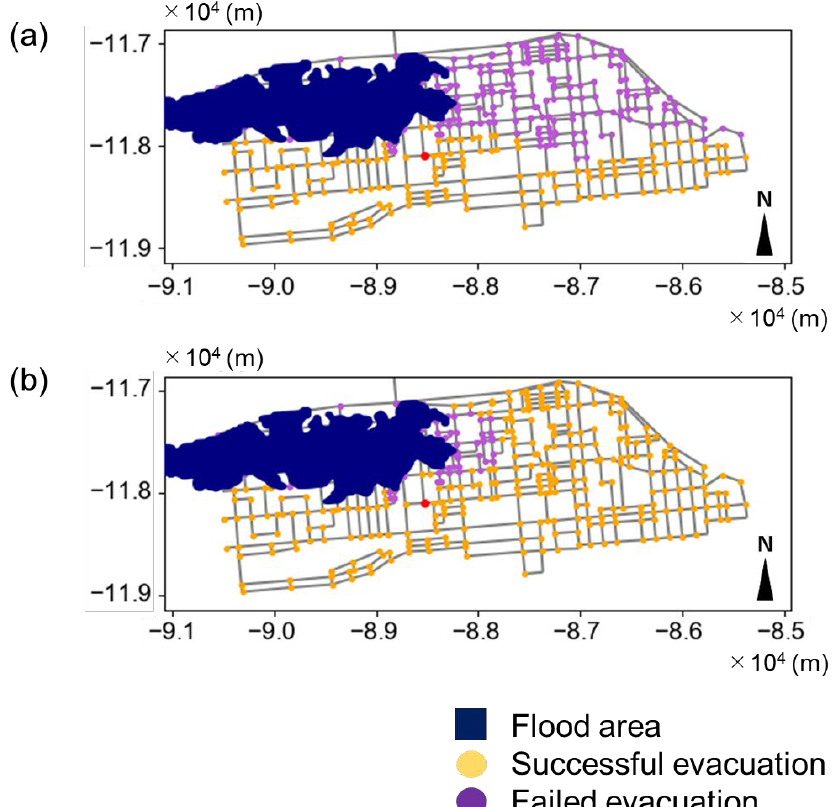
Figure 8. The evacuation conditions of the two models at the start time of evacuation t = 60 (min) in Case (1), ( a ) Model I, ( b ) Model II. Yellow points indicate successful evacuation, and purple points indicate failed evacuation. The x- and y-axes indicate the axis in the Japan Plane Rectangular Coordinate System Xll.